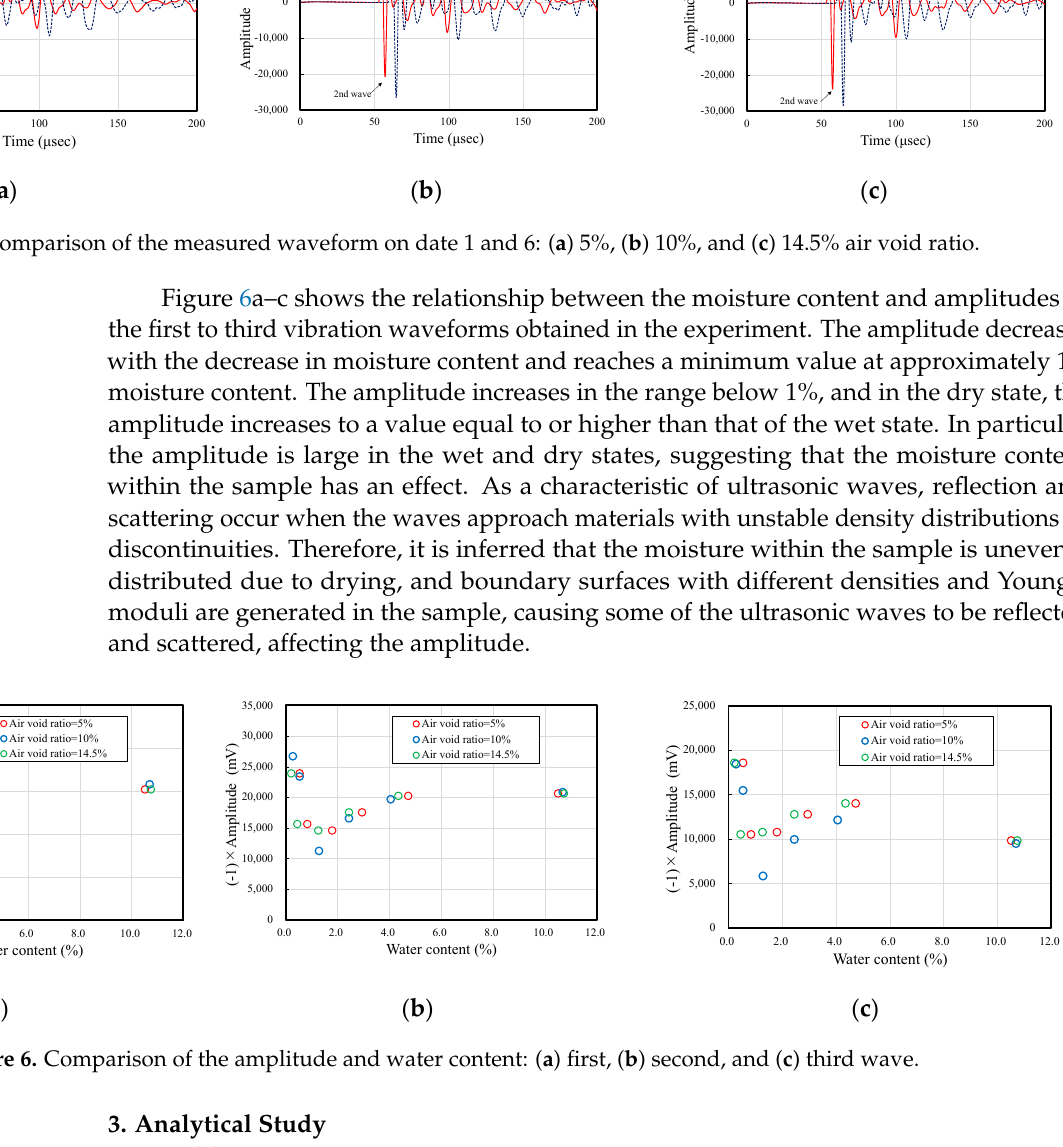
Figure 4. Relationship between the water content and propagation velocity.